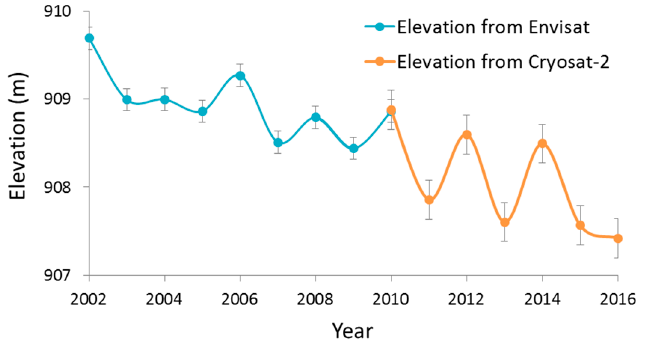
Figure 13. Annual elevation results from Envisat and CryoSat-2 (2002–2016). The blue line shows the